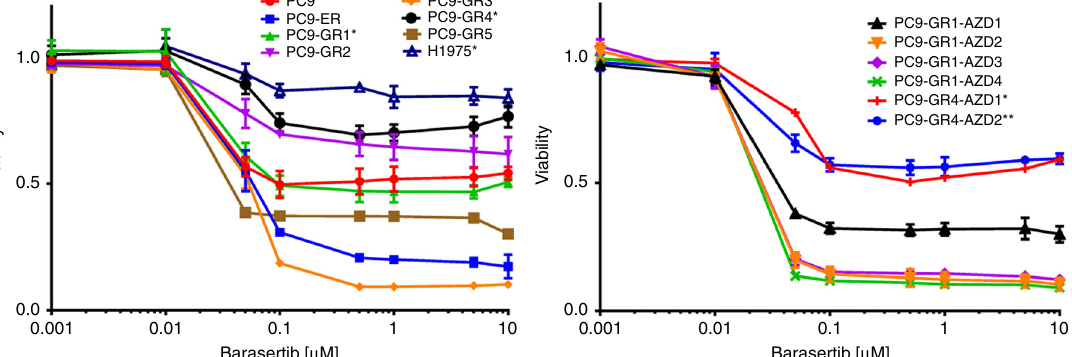
Fig. 1 Characterization of a panel of PC9-derived cell lines resistant to EGFR TKIs. a Diagram summarizing the establishment of the panel. Asterisks indicate cell lines harboring the p.T790M-resistant mutation at >0.1% (*) or < 0.1% (**) allelic fraction. b Western blot analysis of proteins and phospho-proteins related with the emergence of resistance. pFRS, phospho-FGFR substrate 2. c IHC of AXL. d IHC of GAS6. Scale bars indicate 50 μ m. e Dose-response curves of the parental, the EGFR-TKI-resistant and the H1975 cells to the AURKB inhibitor barasertib at 72 h. Values shown are means ± standard deviation (SD), experiments were conducted in tri ( n = 3) or quadruplicates ( n = 4). In each experiment, every concentration of drug was tested in sextuplicates